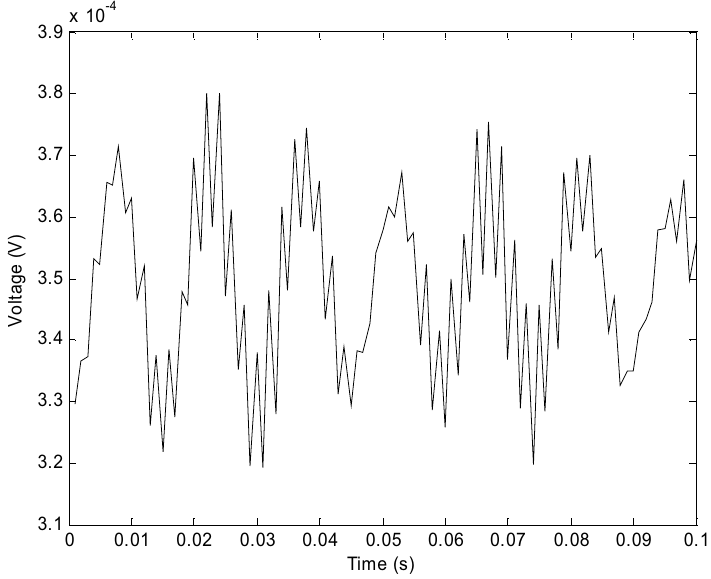
Fig. 15. PZT sensor voltage for the system rotating at 40 Hz. An upward step force is acting at the tip of the opposite blade. 180 Hz and 260 Hz frequencies with less amplitudes. The PZT voltage reflects rather the vibrations at the root